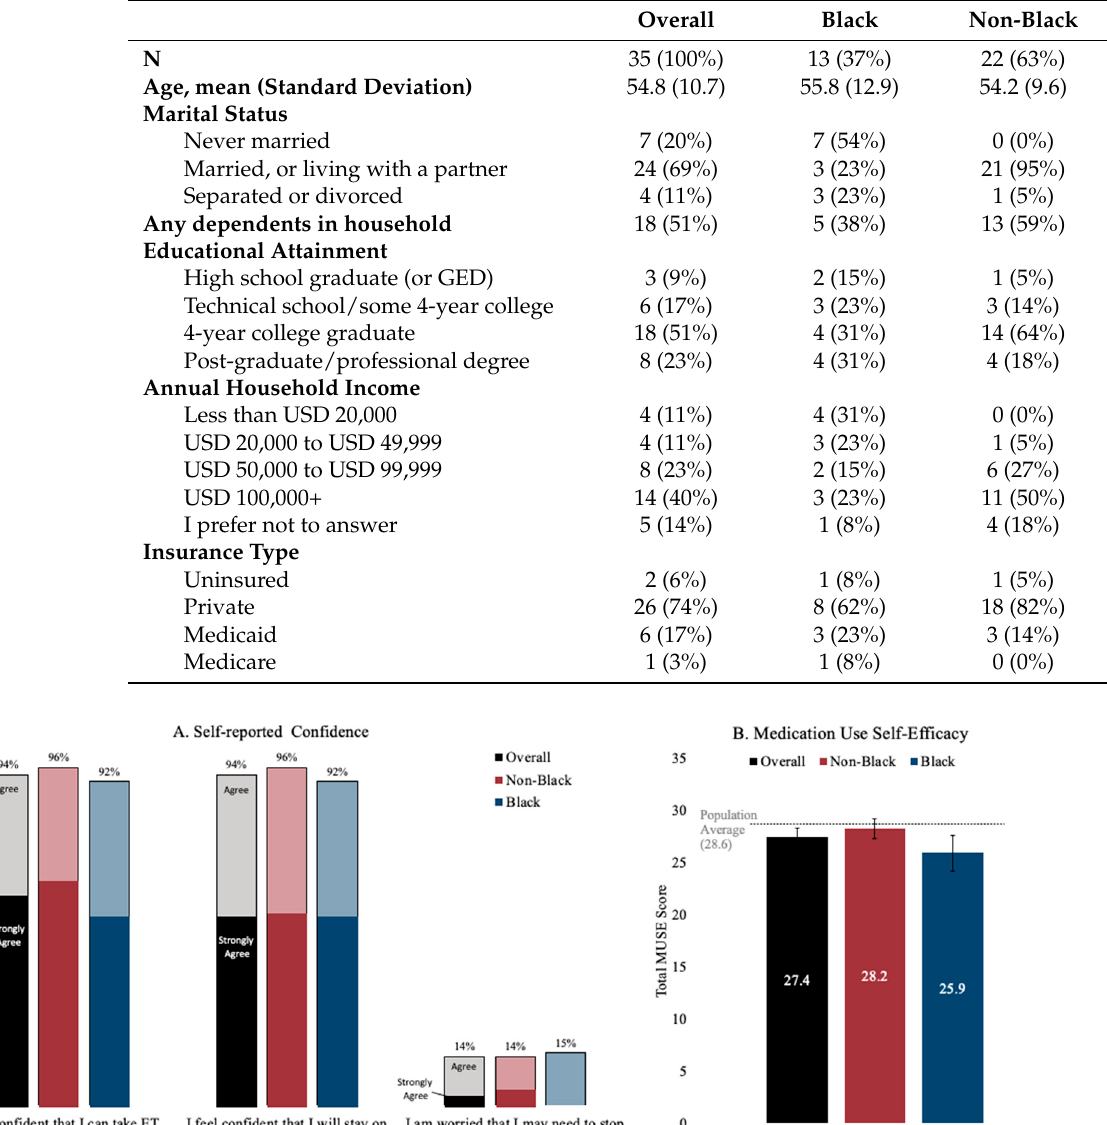
Table 1. GETSET participant characteristics by race.